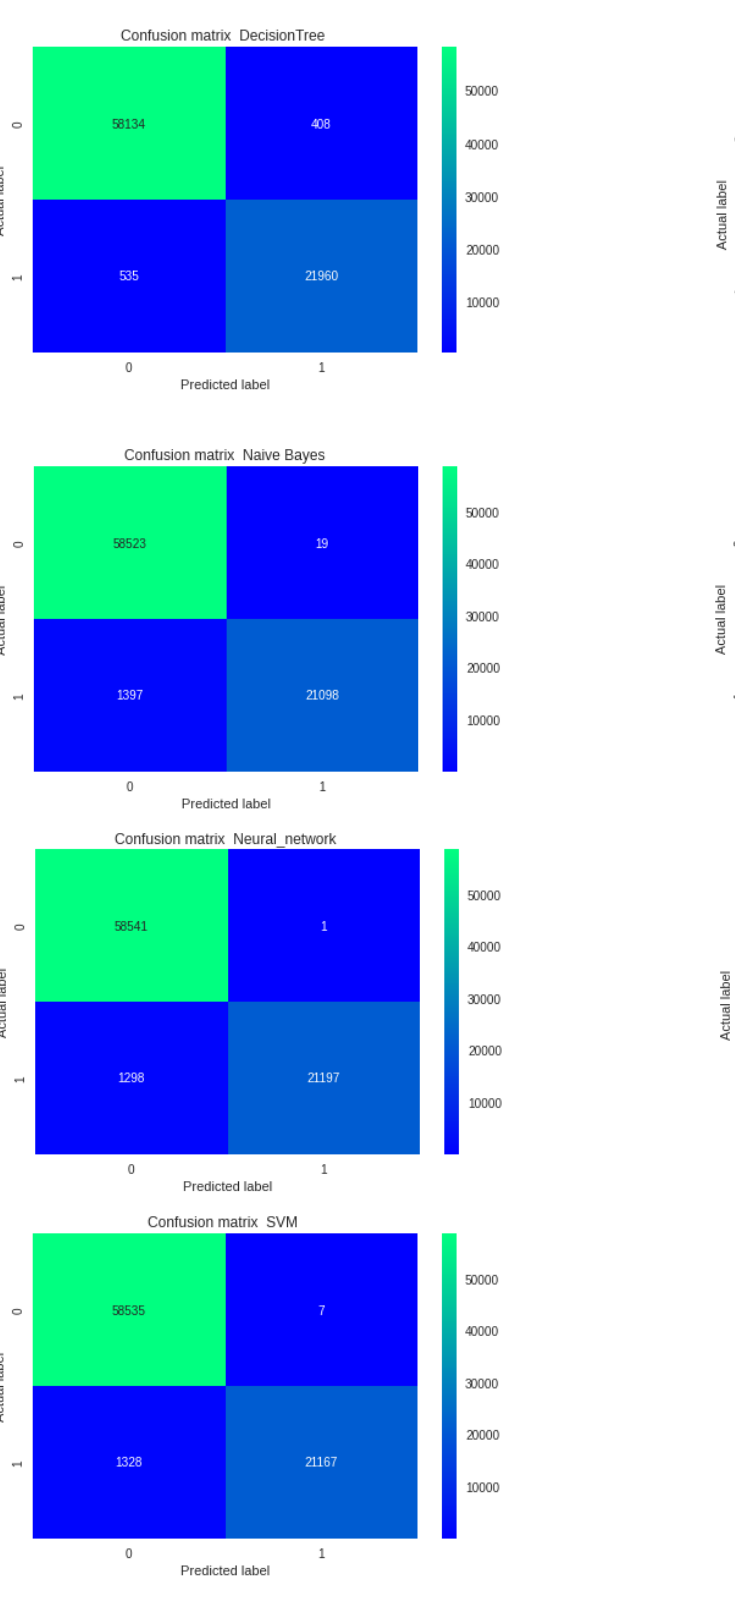
Figure 6. Confusion matrix referring to the